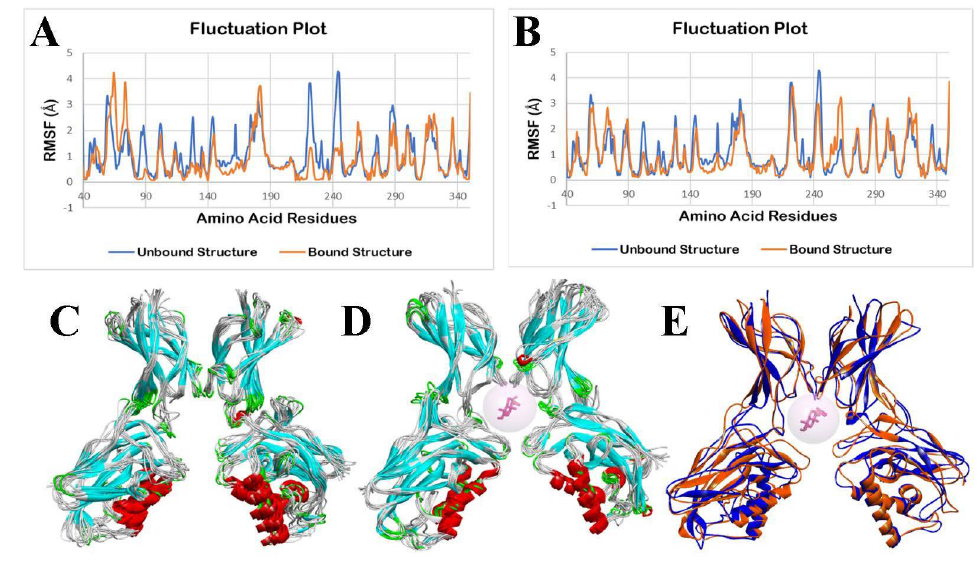
Figure 19. Molecular dynamics simulation of unbound and 14 − deoxy − 14,15 − dehydroandro- grapholide bound NF − κB p50 structures: ( A ) fluctuation plot of the number of amino acid residues of unbound (blue) and bound structure (orange) of NF − κB p50 chain A, ( B ) fluctuation plot of the number of amino acid residues of unbound (blue) and bound structure (orange) of NF − κB p50 chain B, ( C ) superimposition of unbound NF − κB p50 structures from 0 ns to 10 ns, ( D ) superimposition of 14 − deoxy14,15 − dehydroandrographolide bound NF − κB p50 structures from 0 ns to 10 ns, and ( E ) superimposition of unbound NF-κB p50 at 0 ns and 14 − deoxy − 14,15 − dehydroandrographolide bound NF − κB p50 at 10 ns.